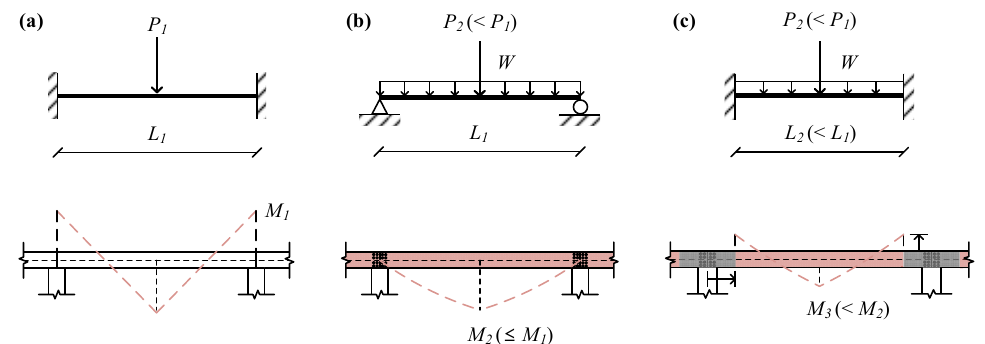
Figure 3. Idealized moment diagram induced by one-way gravity load: ( a ) Main beam in GBG system, ( b ) steel double-beam in double-beam floor system without a concrete panel (DBX) system, and ( c ) steel double-beam in DBO system.